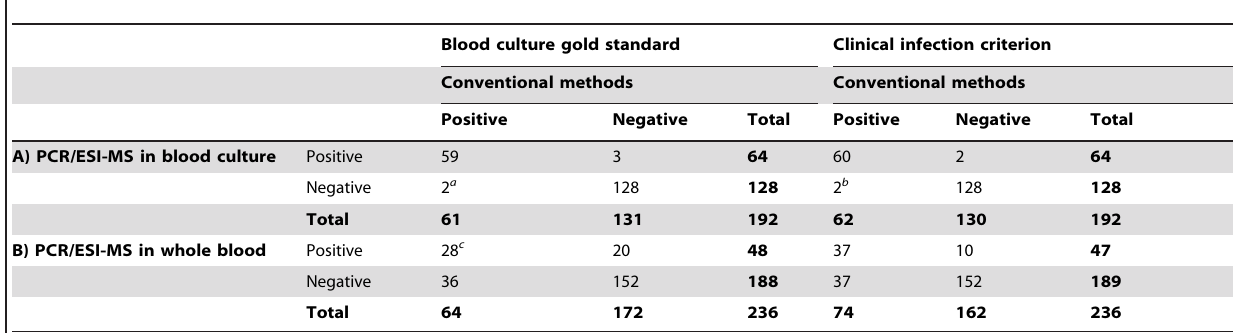
Table 4. Agreement of unique isolation/detection specimens depending on the gold standard used and the specimen